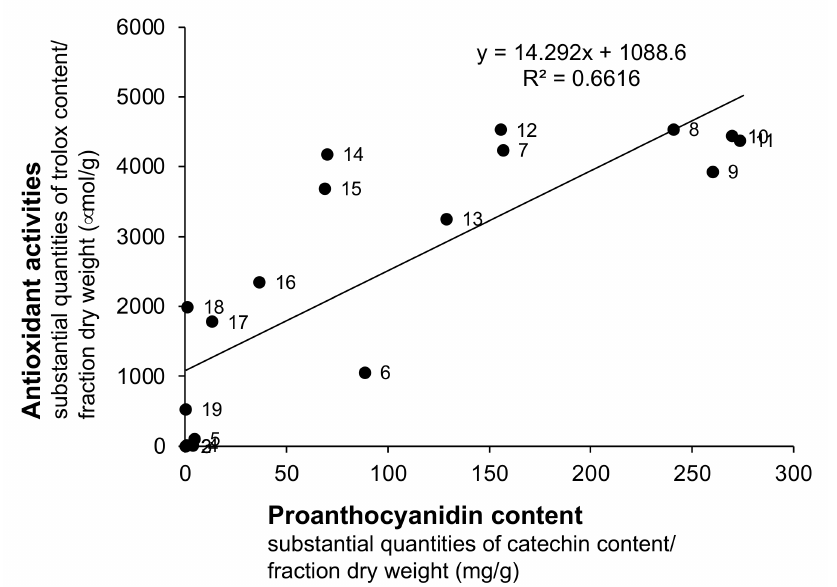
Figure 4. Correlation between Proanthocyanidin content and Antioxidant activities of Fractions from Water Extracts of V. virgatum stems. The label on each plot indicates the fraction number. Fraction 1 cannot be displayed because it could not be detected by the antioxidant